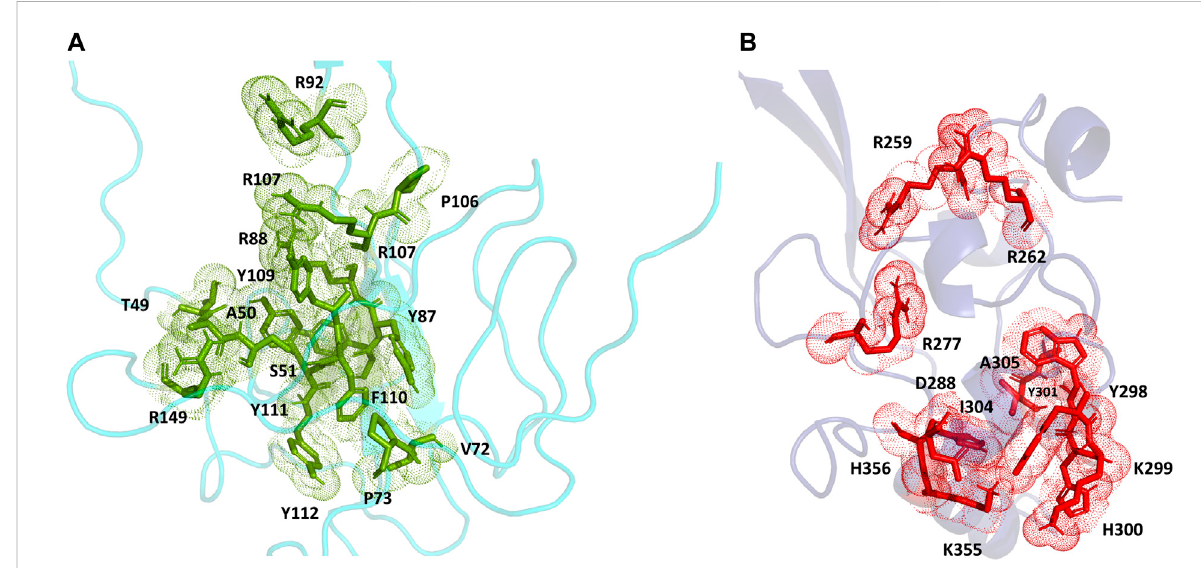
FIGURE 10 (A) The POOL-predicted residues for the SARS-CoV-2 Nucleocapsid protein N-terminal model built in YASARA (B) The POOL-predicted residues for the SARS-CoV-2 Nucleocapsid protein C-terminal structure from the PDB (PDB ID: